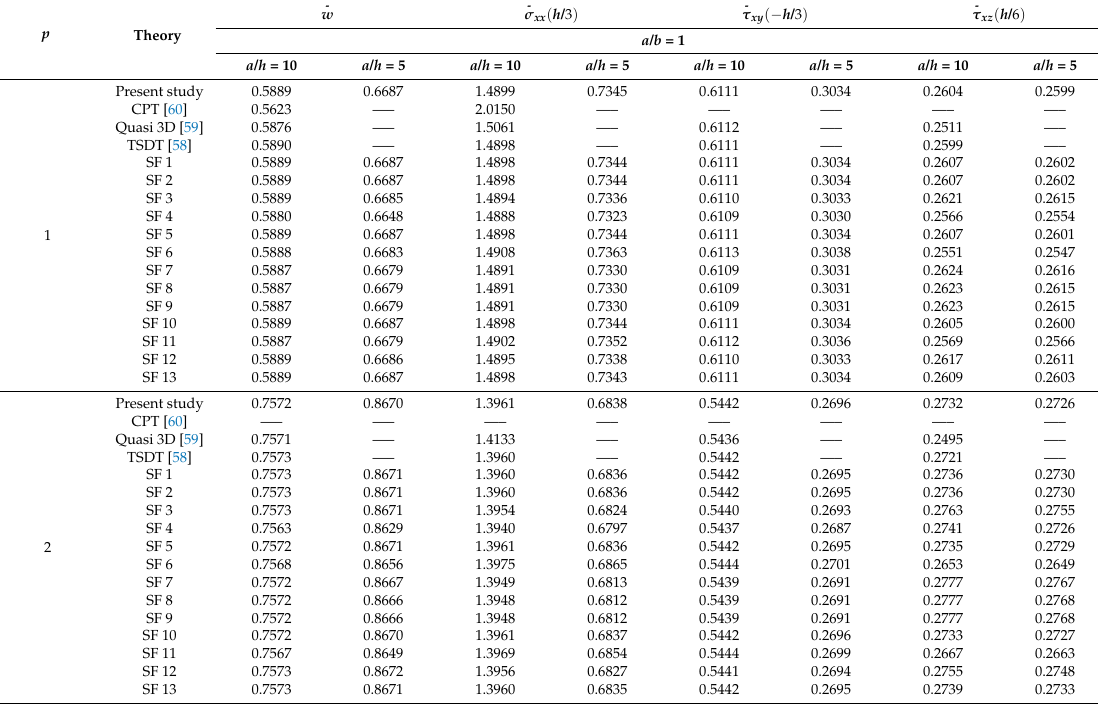
Table 3. Normalized values of displacement and stresses of square plate for different values of the index p and the ratio a / h ( a / b = 1). CPT: classical plate theory; TSDT: third-order shear deformation